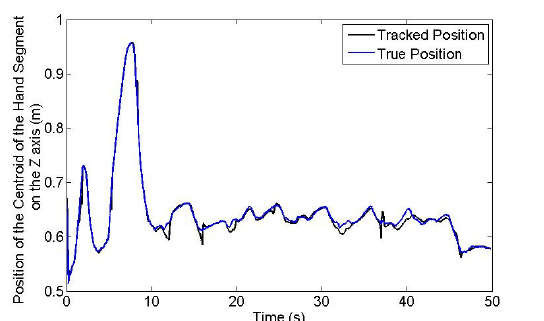
Figure 3. Evaluation of the tracking method: Comparison between tracked and true positions of the hand centroid On the Z